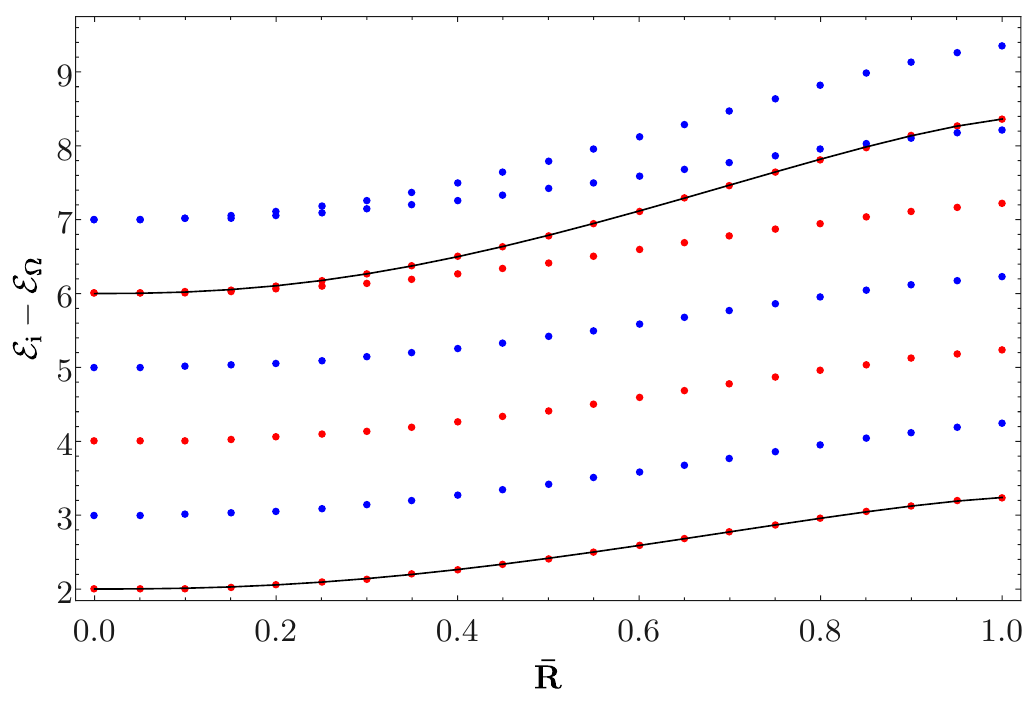
Figure 20. Spectrum of the Lee-Yang model. All the data points are computed with cutoff Λ = 40 . To avoid clutter, we did not plot the extrapolated data with their error bars, although the latter would be pretty small up to ¯ R ∼ 0 . 8 as in figure 19. As discussed in text, we cannot trust the data beyond ¯ R ∼ 1 , due to large truncation